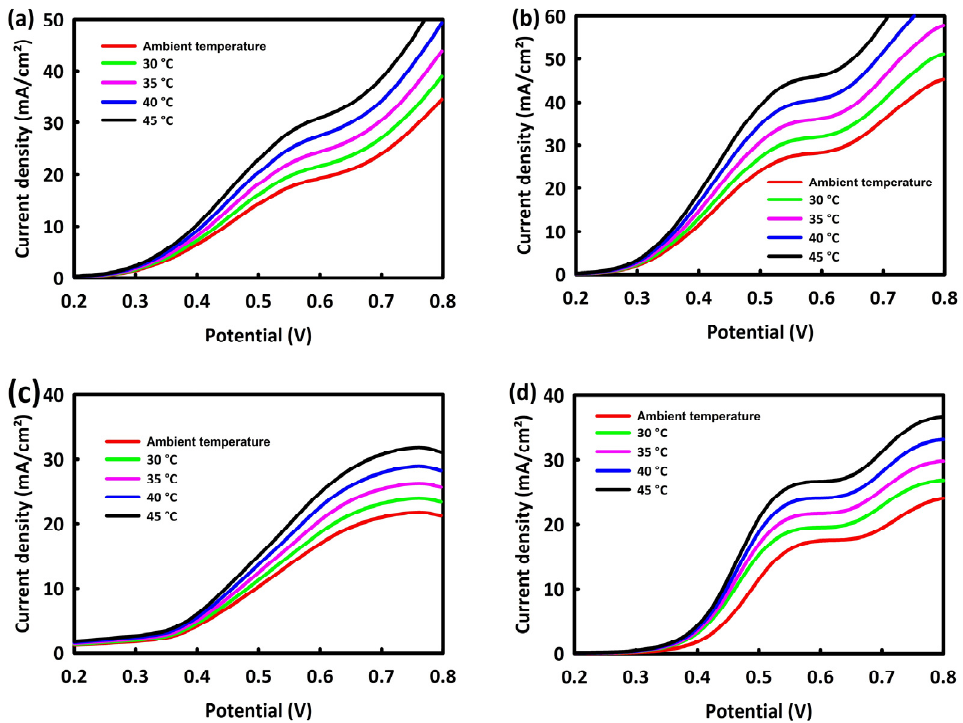
Figure 7. LSV curves of ZrO 2 /NiO ( a ) and ZrO 2 /NiO/rGO ( b ) in MOR process and LSV of ZrO 2 /NiO ( c ) and ZrO 2 /NiO/rGO ( d ) in EOR process at different temperatures. Table 1. Comparison of MOR and EOR performances of ZrO 2 /NiO/rGO nanocatalyst with other research.